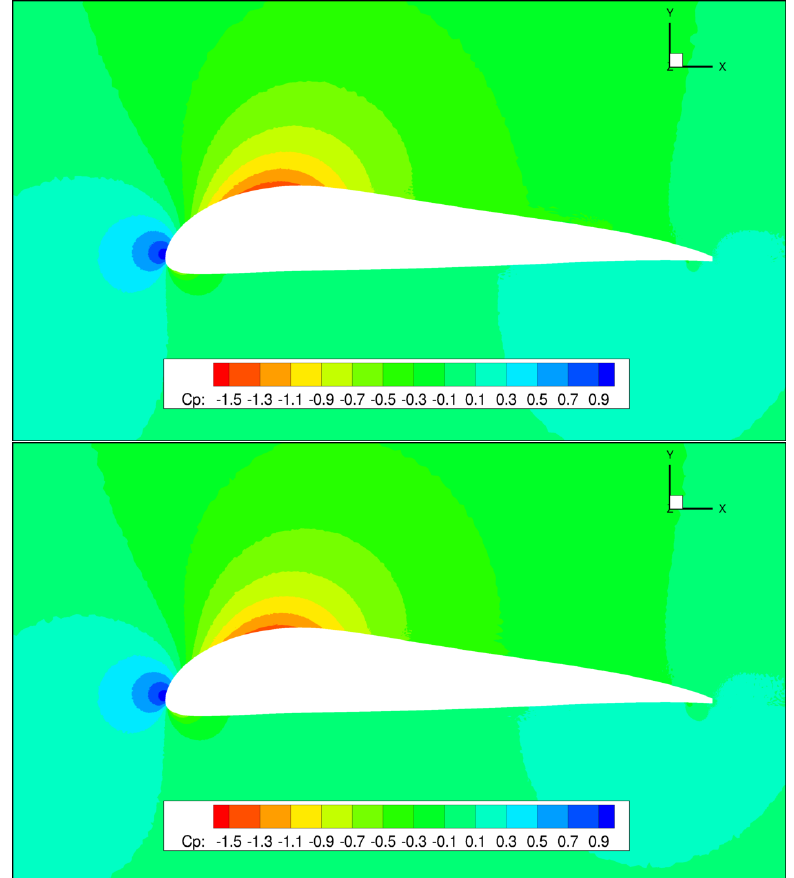
Figure 13. Comparison of full suction and oscillatory blowing ( top ) and plain oscillatory blowing ( bottom ) cases. Both simulations were run with an oscillation frequency of 300 Hz, and Angle of Attack (AoA) = 0 ◦